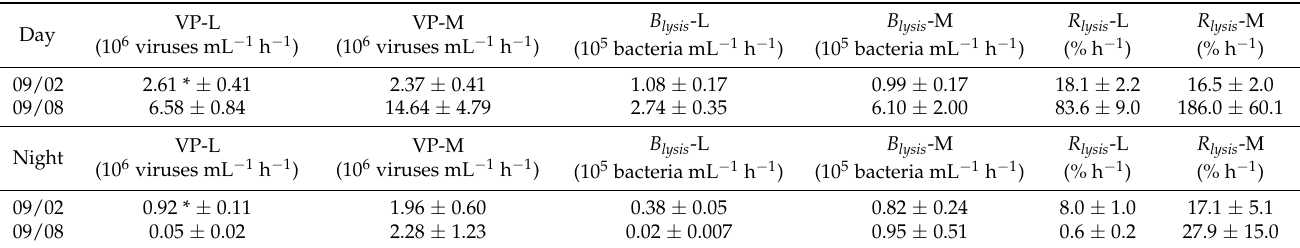
Table 2. Viral production (VP), bacterial mortality by viral lysis ( B lysis ), and percentage of bacteria lysed ( R lysis ). VP is calculated from the linear regression between VLP and time (VP-L) and arithmetic mean of VP during incubation (VP-M). B lysis -L and R lysis -L are calculated based on VP-L and B lysis -M and R lysis -M based on VP-M, respectively. The standard deviations of the three replicate incubations are presented after ± . Asterisk symbol indicates that the linear regression between mean VLP and incubation time is